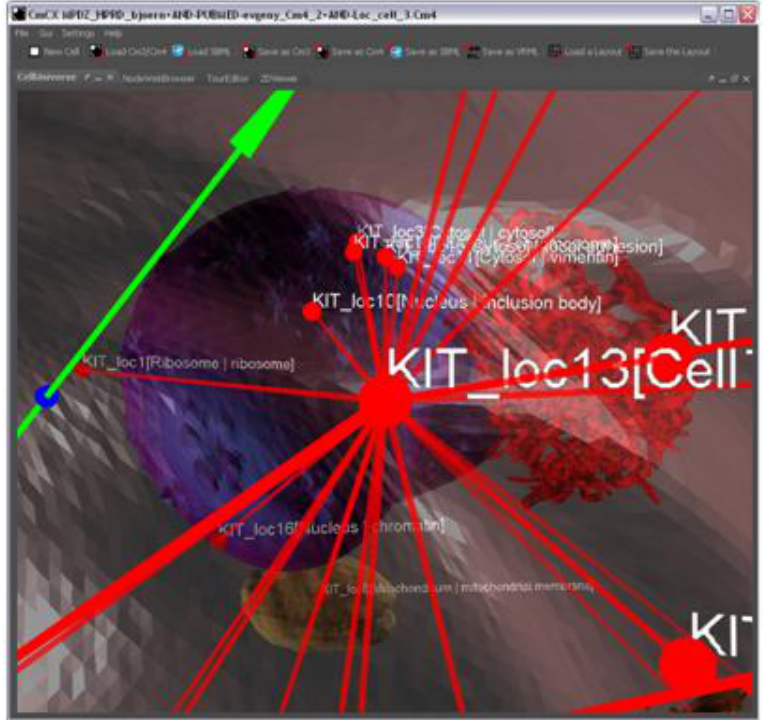
Figure 12: Focusing KIT, the incoming reaction from MPDZ (thick red line) and connections to the alternative locations (thin red lines) are shown, like the Ribosome, Nucleus and